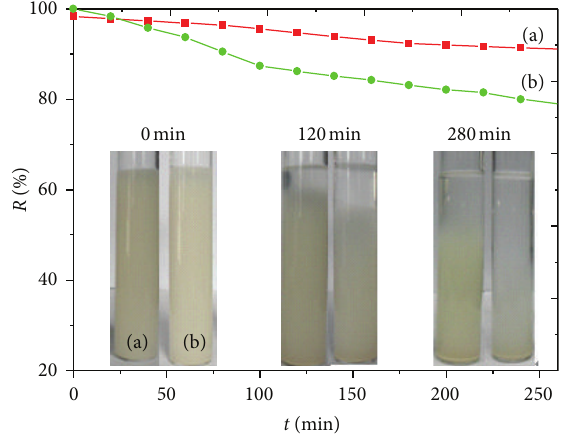
Figure 7: The settling curves of (a) pure yeast and (b) HPW@yeast